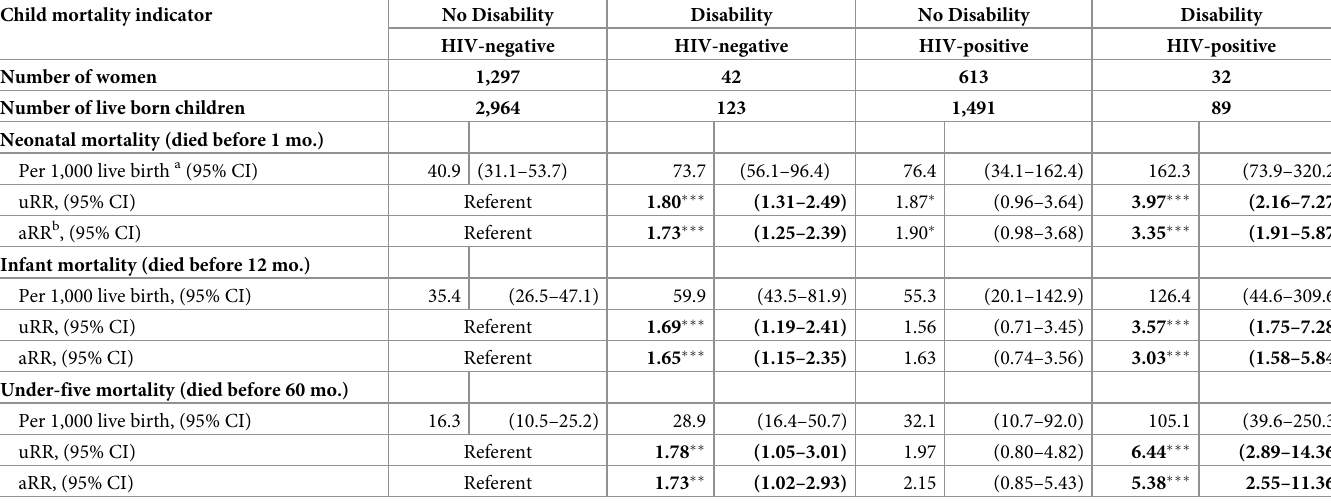
Table 2. Rates, unadjusted and adjusted risk ratios (with 95% confidence intervals) for child mortality indicators by maternal disability and HIV status, N = 4,667 live-born children to 1,984 mothers. Child mortality